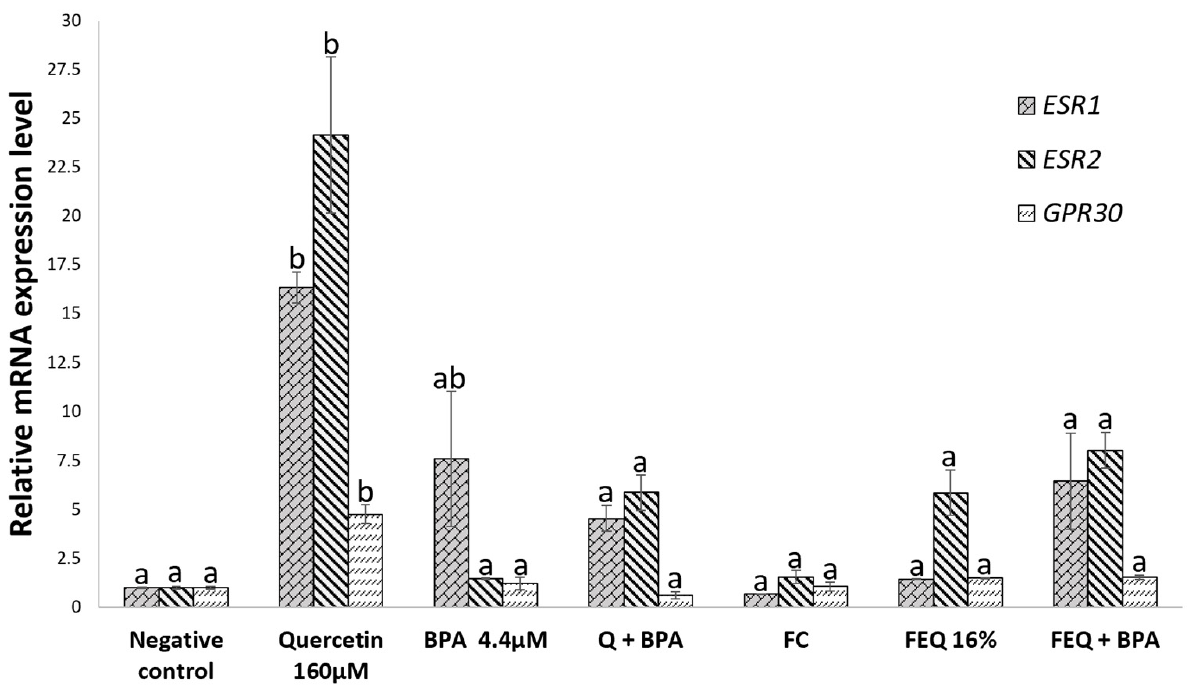
Figure 7. Effect of Q and FEQ co-exposed with BPA on the expression of estrogen receptors α , β and GPR30 on HT-29 colon cells. Concentration of treatments: Q 160 µ M, BPA 4.4 µ M, FEQ 16%. FC: fermentation control. Each value represents the mean of a duplicate experiment ± ES. Different letters indicate significant differences between treatments of each gene ( p < 0.04) by Tukey’s test. The expression of the treatments was normalized with the housekeeping gene actin.